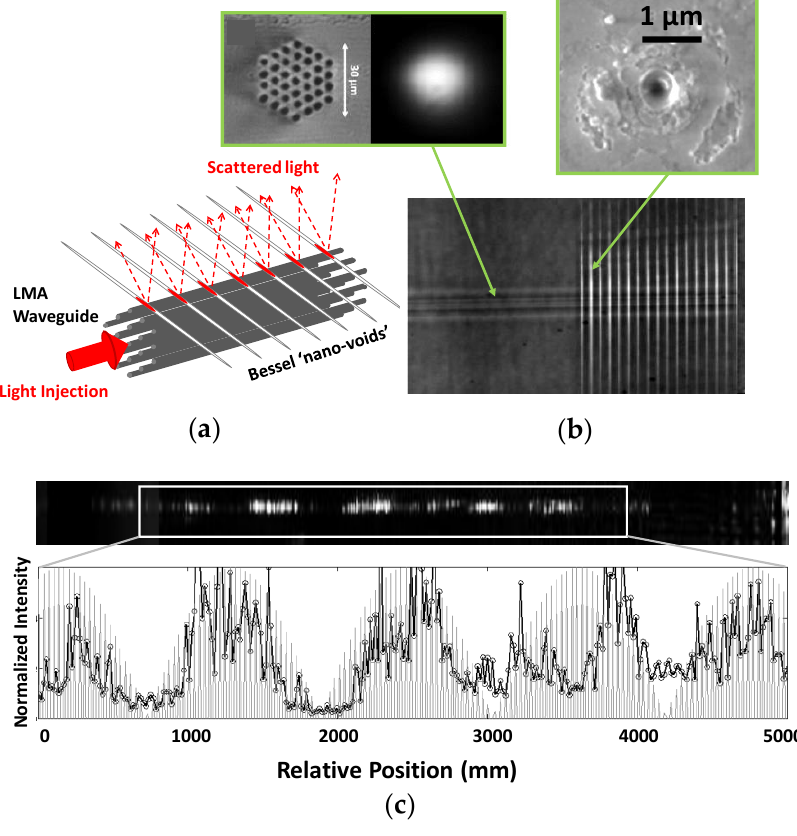
Figure 9. ( a ) Schematic concept of LMA light transport and signal extraction optical functions, obtained by using multicore array waveguide concept (for guiding) and high aspect ratio Bessel nano-voids photo-written transversally to the waveguide (signal extraction by scattering); ( b ) Top-view of the prototype schematized in ( a ) fabricated in bulk GLS glass. The inset on the left shows the multicore cross-section of the fabricated LMA waveguide and the corresponding guided mode obtained by injecting the waveguide with a 1550 nm SLED. The inset on the right shows the cross-section of the single Bessel nano-void structure; ( c ) Sampling of the λ = 3.39 µm signal confined in the waveguide and extracted from the periodic Bessel nano-voids (input injection on the left, output interface on the right). Although the signal is under-sampled (discussion in the text), a stationary wave is clearly visible as formed in the waveguide by interference.